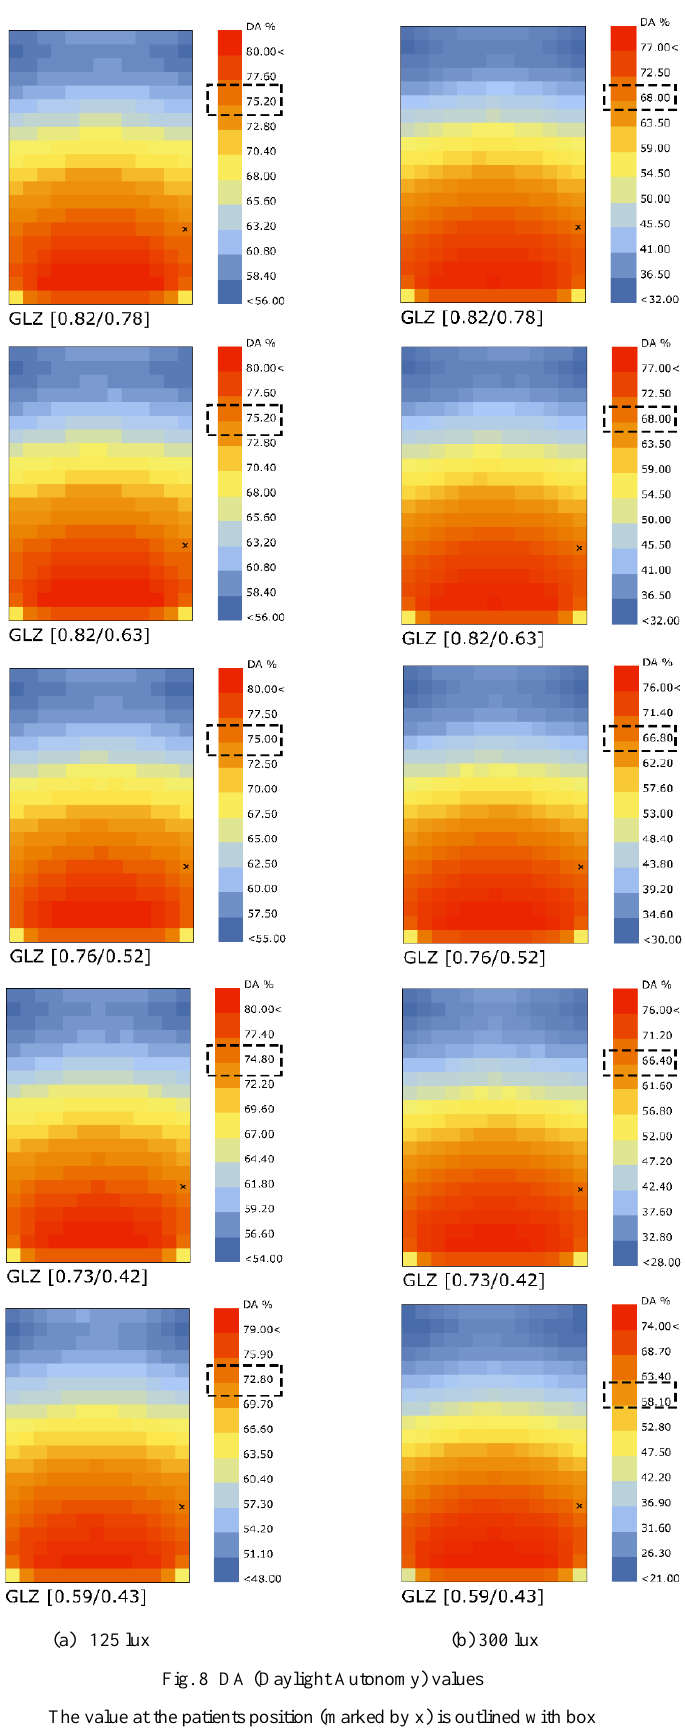
Fig. 8 DA (Daylight Autonomy) values The value at the patients position (marked by x) is outlined with